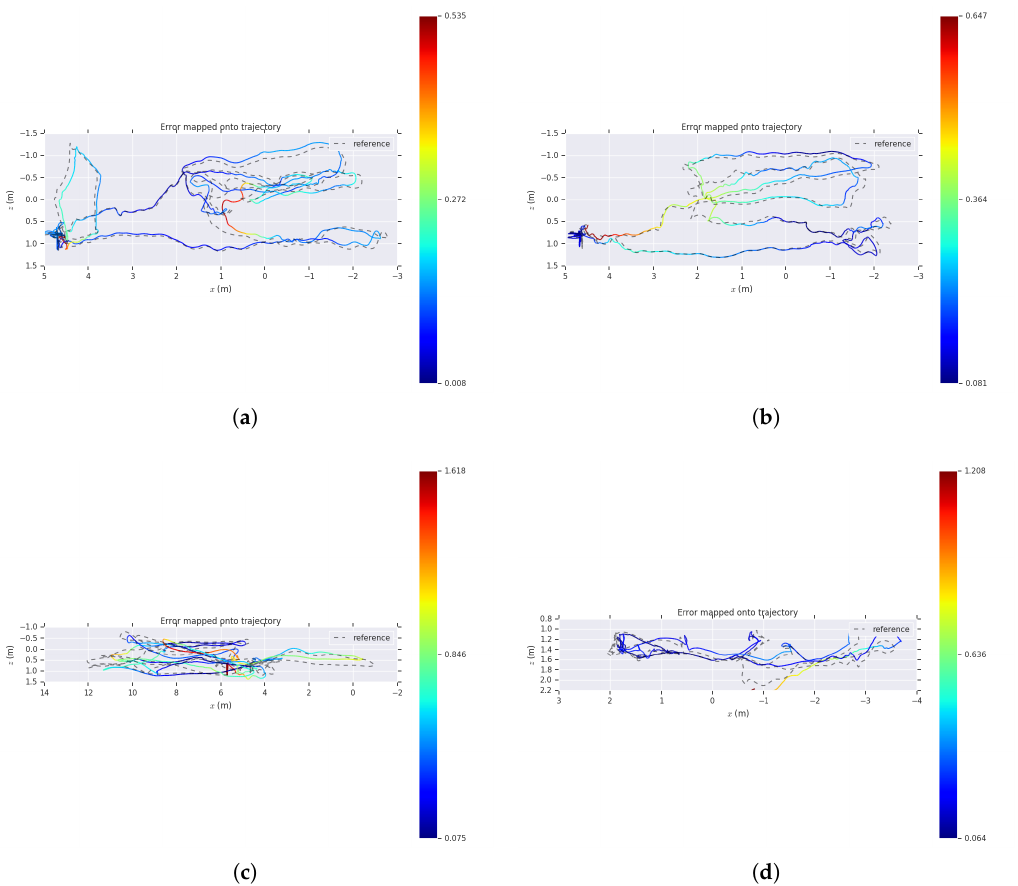
Figure 8. The comparison of the estimated pose trajectory and the ground-truth on several EuRoC sequences. ( a ) MH _01_ easy ; ( b ) MH _02_ easy ; ( c ) MH _03_ medium ; ( d ) V 2_01_ easy . The dashed line indicates the reference trajectory, the solid line is the trajectory estimated by our algorithm, and the color indicates the absolute pose error (APE) error from the true